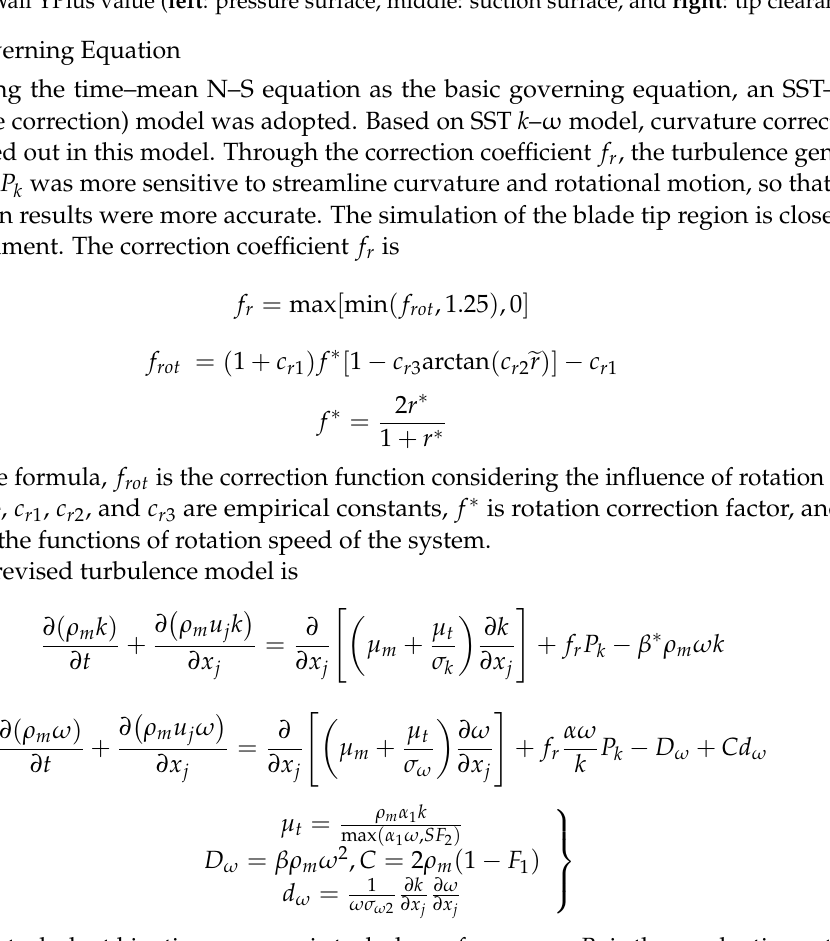
Figure 5. Wall YPlus value ( left : pressure surface, middle: suction surface, and right : tip clear- ance).